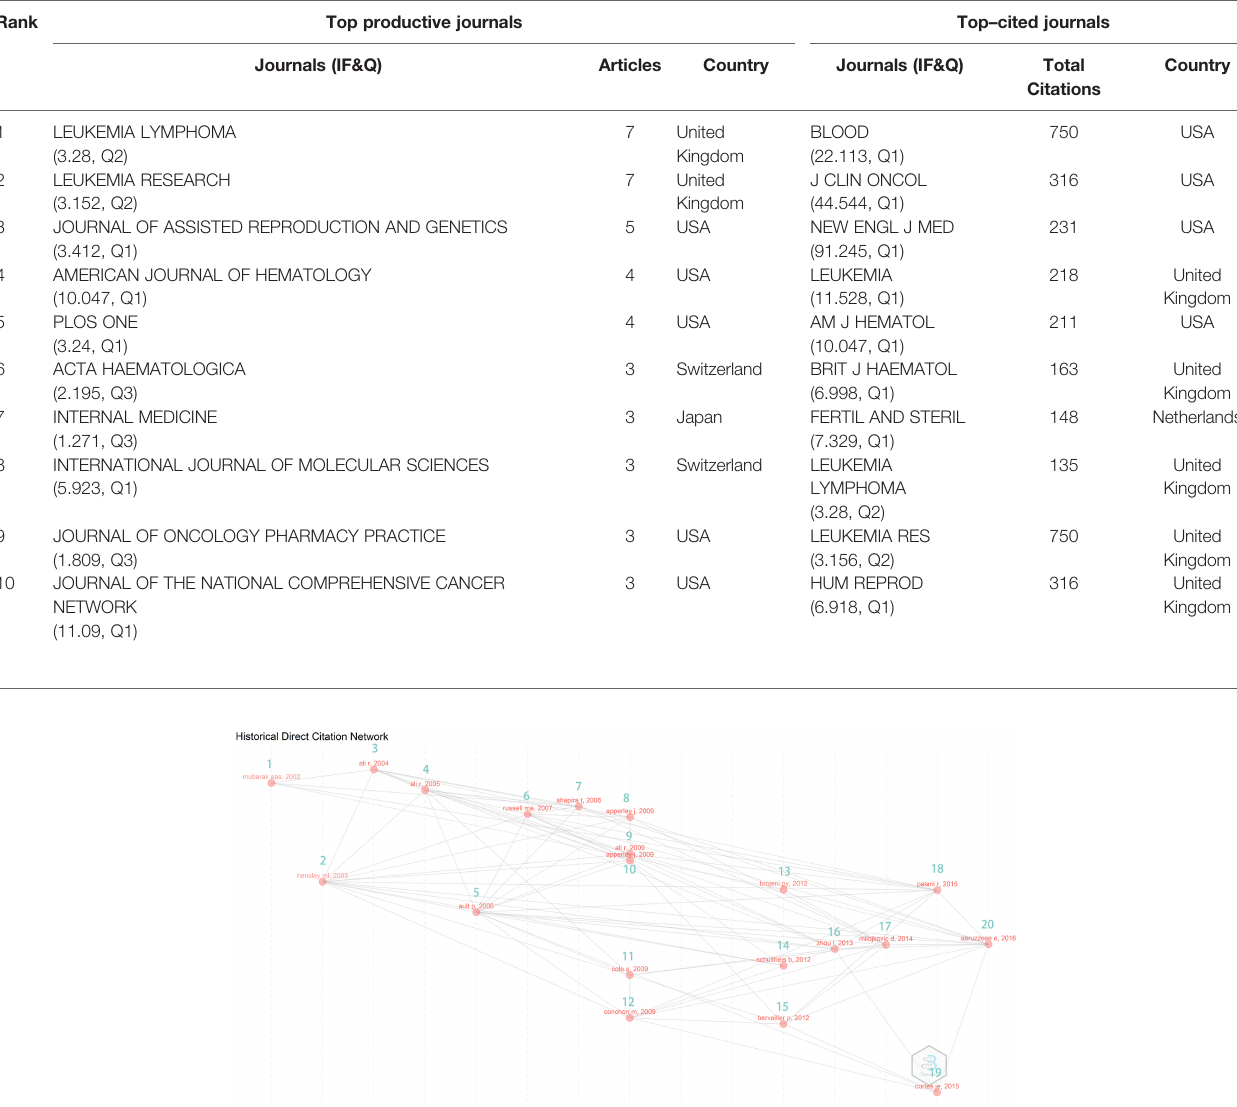
TABLE 2 | Distribution by top journals and its citations.